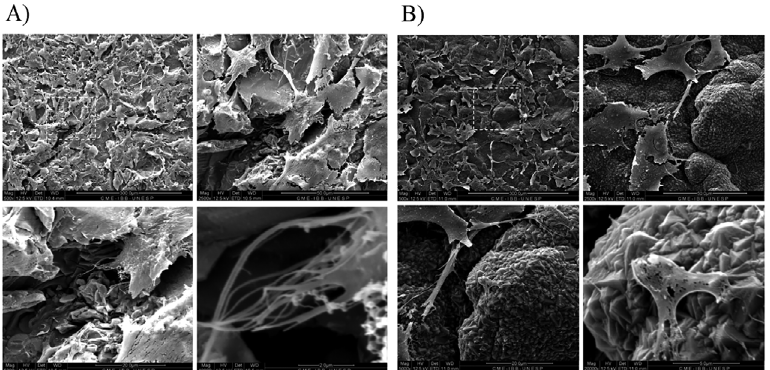
Figure 9. Scanning electron microscopy of osteoblast cells on rough titanium without (left) or with (right) the diamond film.